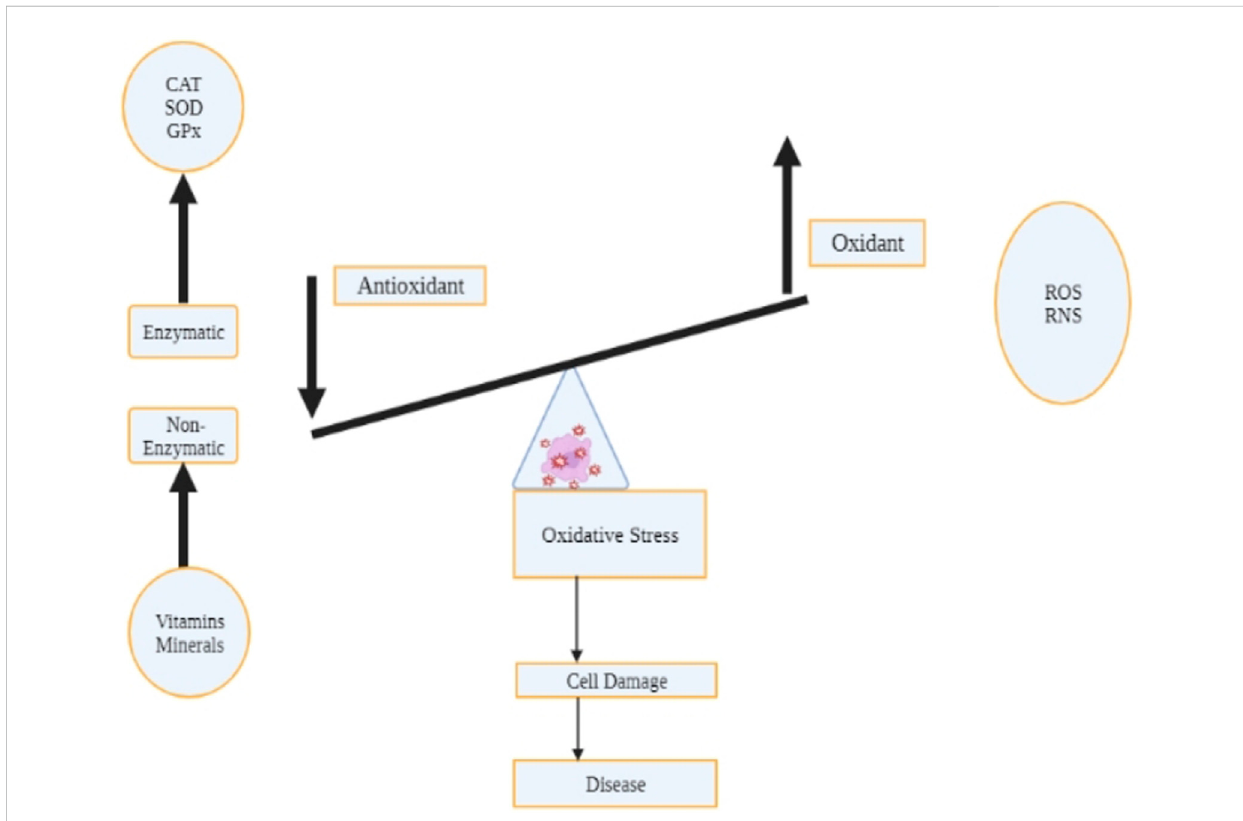
FIGURE 1 The status of oxidative stress hangs on the balance of the production of the reactive oxygen species and the antioxidant processes and biological compounds.Celldamageduetooxidationresultsfromthedownregulationofnon-enzymaticcompounds(mineralsandvitamins)facilitatingantioxidant functions, decreasing reactive oxygen species production. An increase in antioxidant processes and biological compounds decreases ROS production, and the converse is